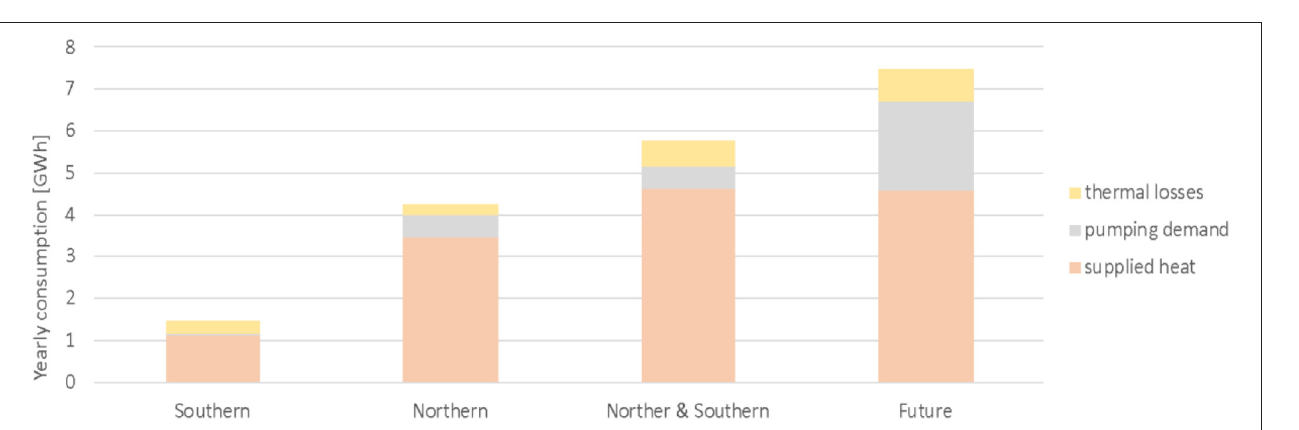
FIGURE 9 | Network-layout performances’